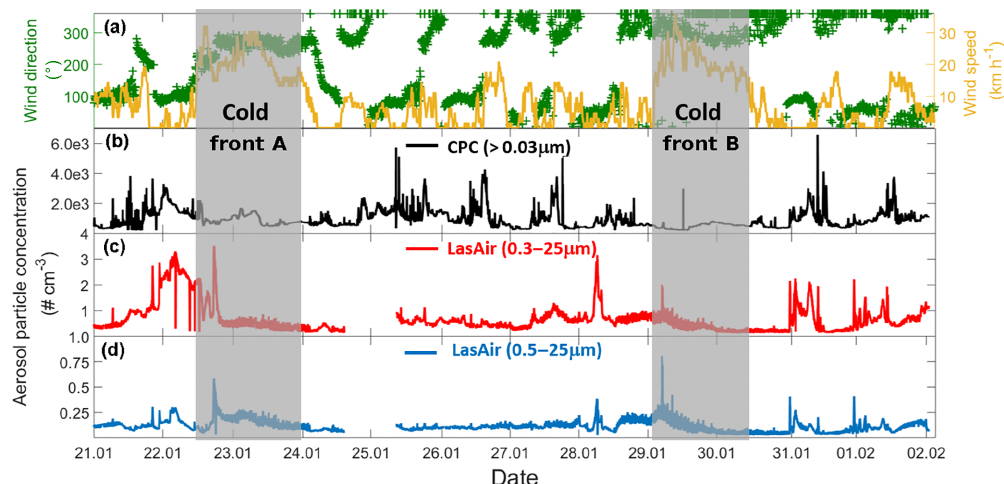
Figure 2. Time evolution of wind and aerosol particle concentration time series for the entire campaign (21 January–2 February 2017). (a) Time series of the wind speed (yellow) and wind direction (green), (b) particle concentration measured by the CPC, (c) particle concen- tration measured by the LasAir full-size range (0.3 to 25µm), and (d) particle concentration measured by the LasAir for particles > 500nm (0.5 to 25µm). Grey areas denote the periods affected by cold fronts A and B. Each tick mark on the x axis corresponds to midnight local time.